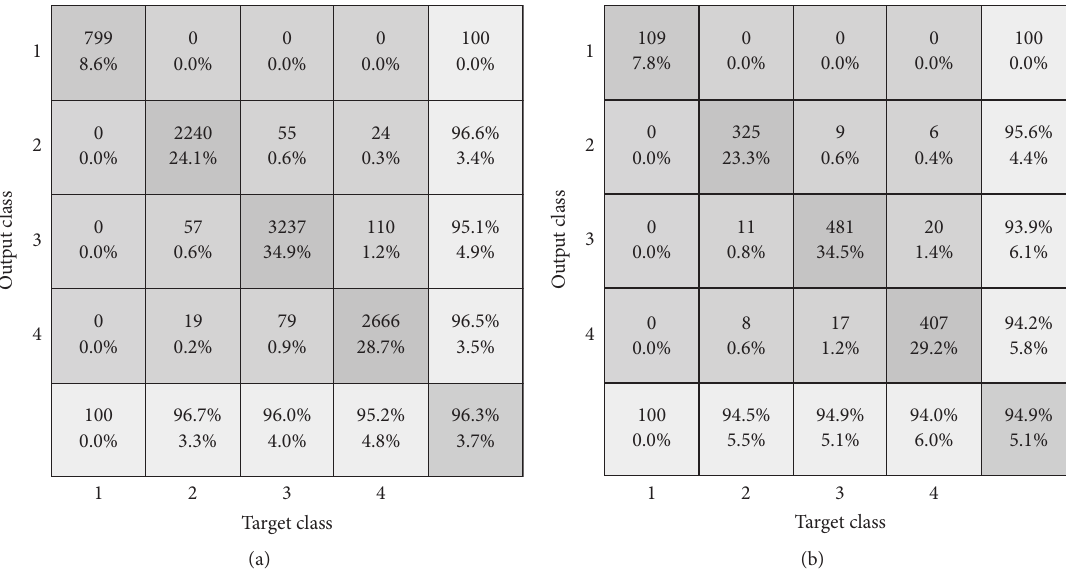
Figure 7: Confusion matrix of training performance: (a) for all dataset and (b) for test set.